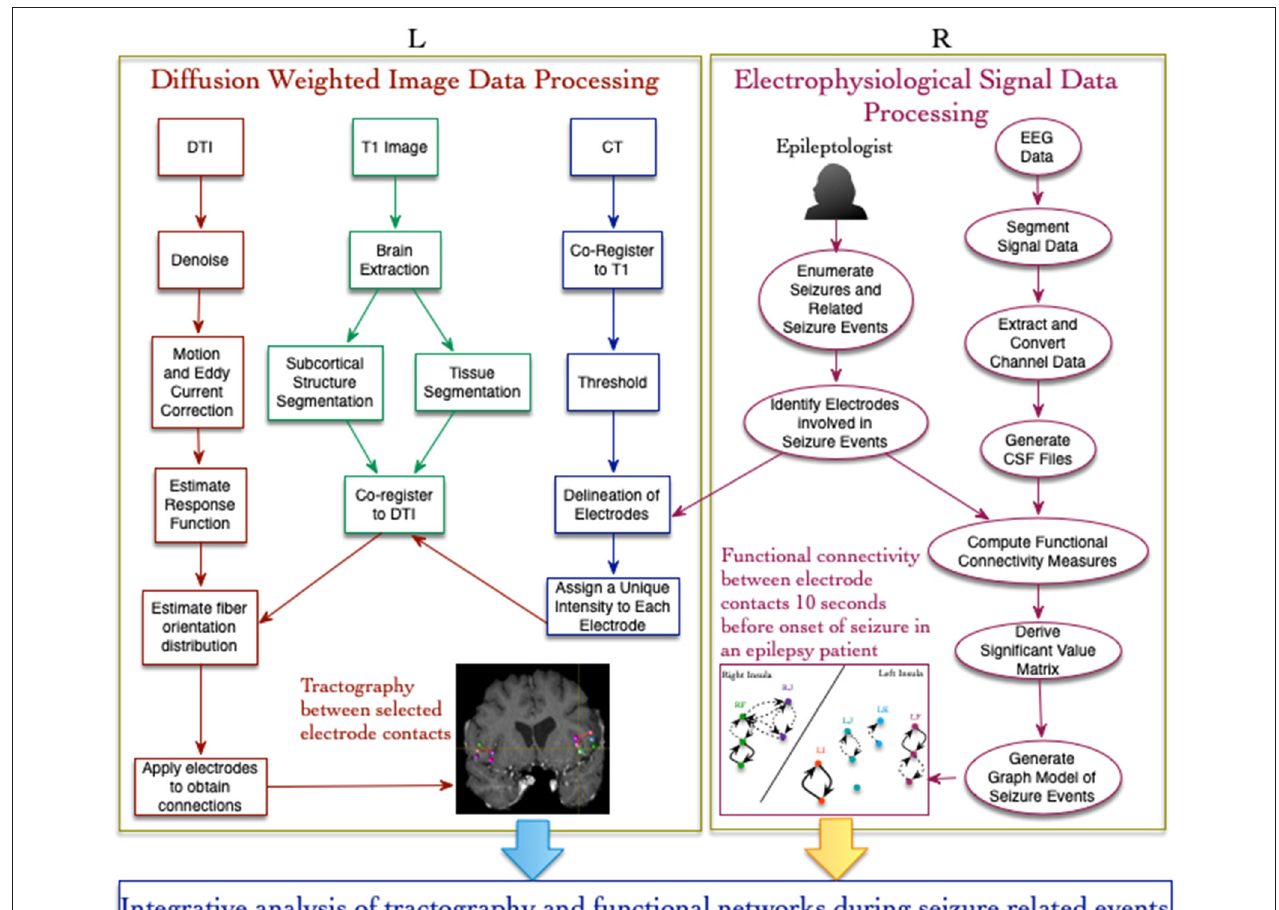
FIGURE 1 | Workflow-based approach for integrative analysis of structural (L) and functional (R) connectivity networks in epilepsy. The structural connectivity workflow (on the left) involves image processing, registration, and use of electrode contacts as constraints for fiber tracting. The functional connectivity workflow (on the right) uses a new signal data format called CSF for computing coupling measures between signal recorded from different brain